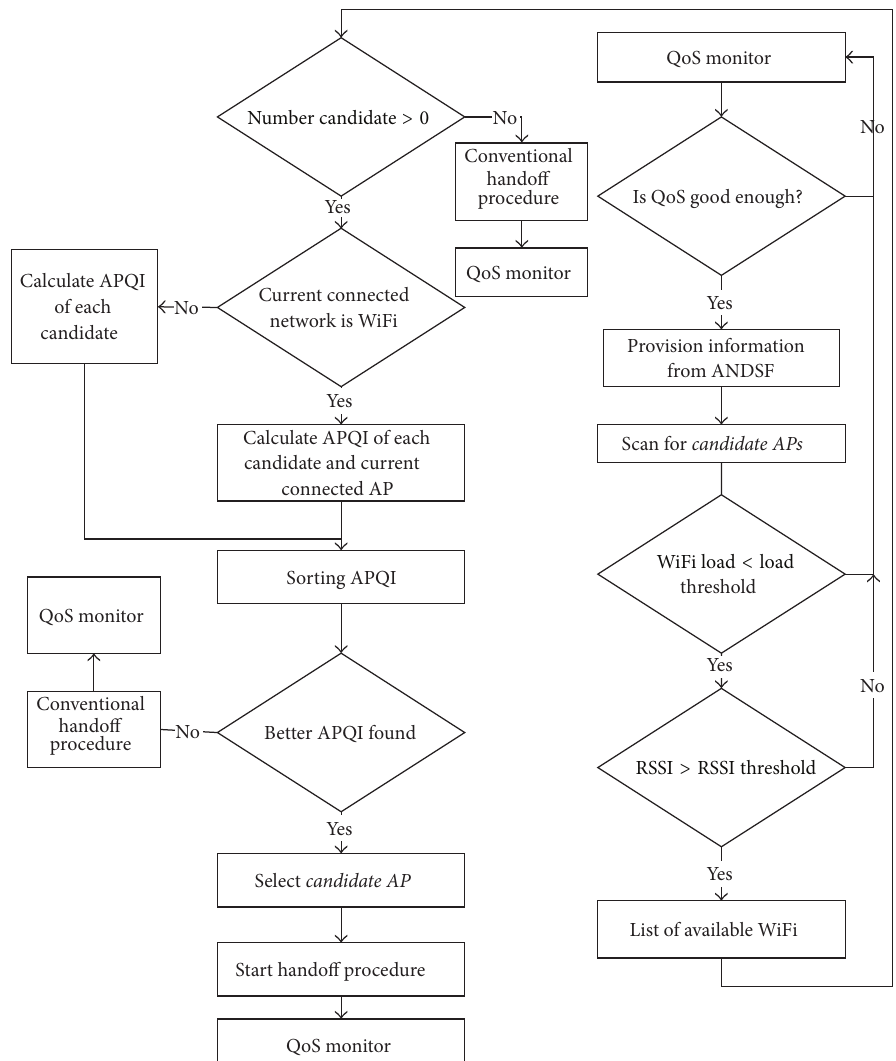
Figure 3: Proposed roaming decision and point of service selection